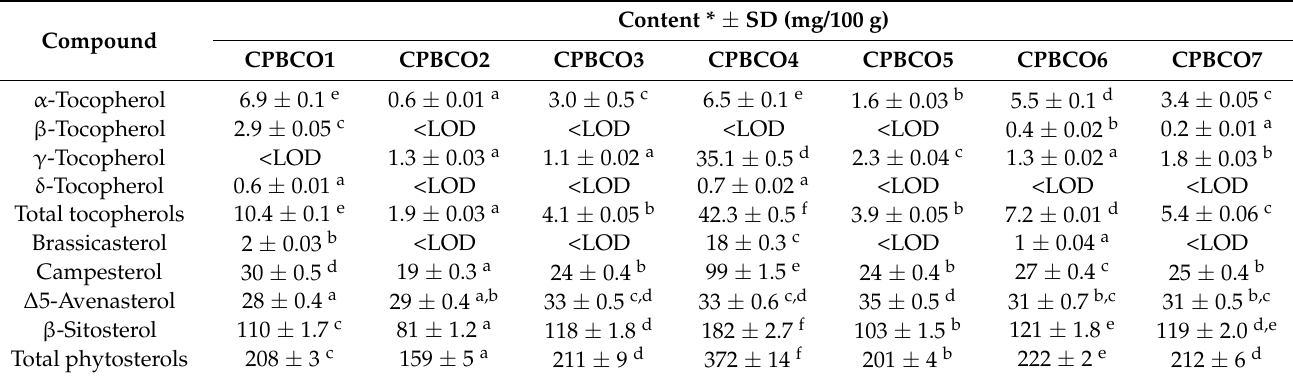
Table 3. The compositions and contents of tocopherols and sterols in cold-pressed black cumin